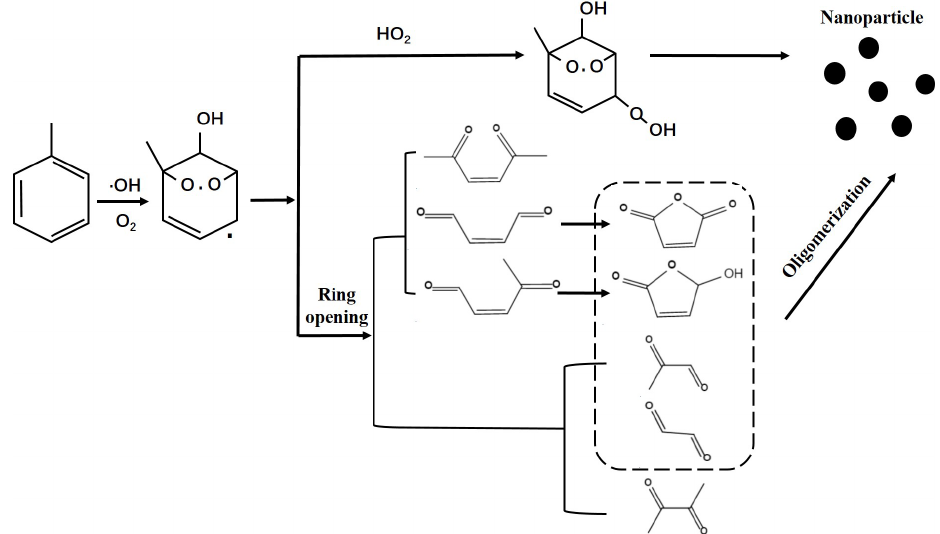
Figure 7. The possible photochemical oxidation mechanism of toluene to SOA